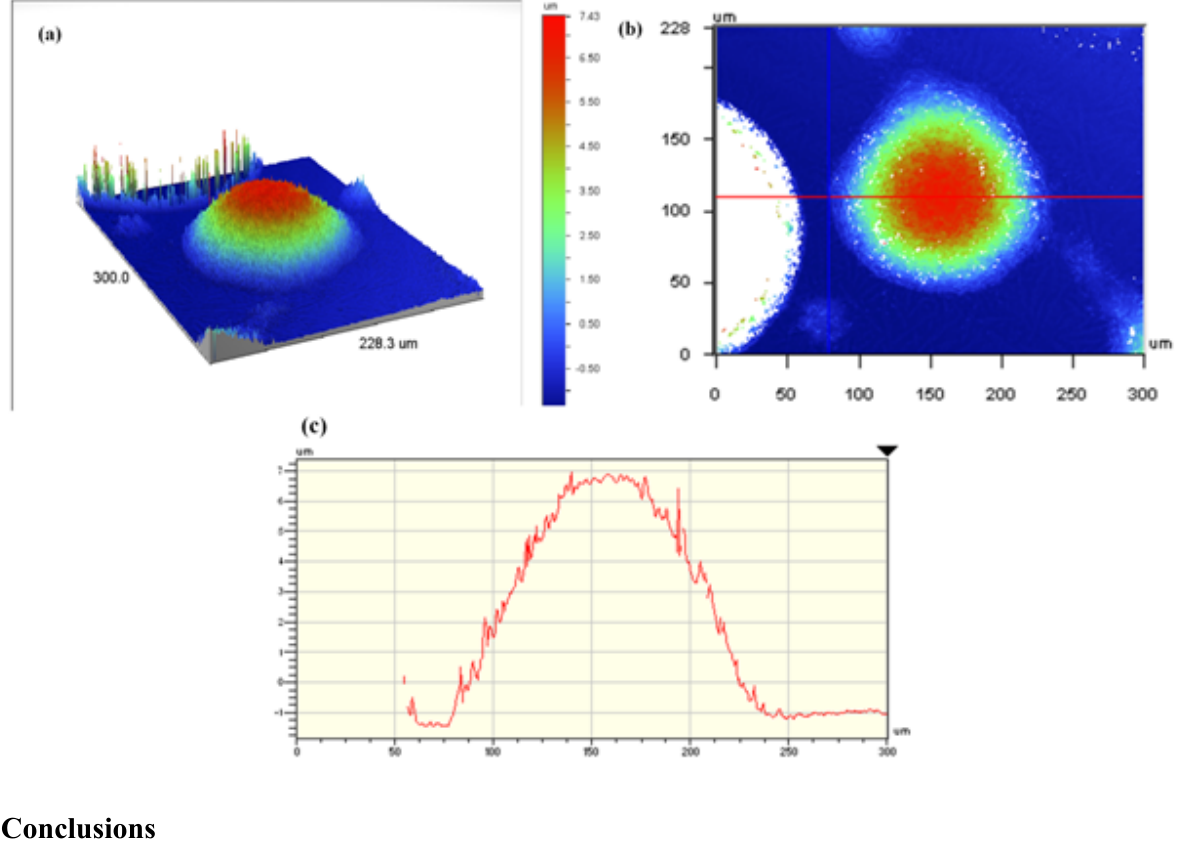
Figure 14. Disk splat scanned by WYKO surface profiler ( a ) 3D display; ( b ) Top view; ( c ) Cross section of